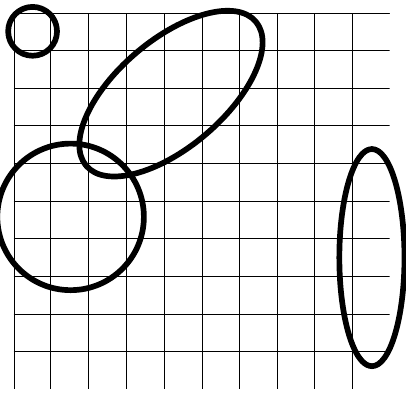
Table 1. Solute transport parameters with pore water velocity v (cm d − 1 ), and dispersivity α (cm) for fast, average, and slow cells, as well as for the entire sampler, for